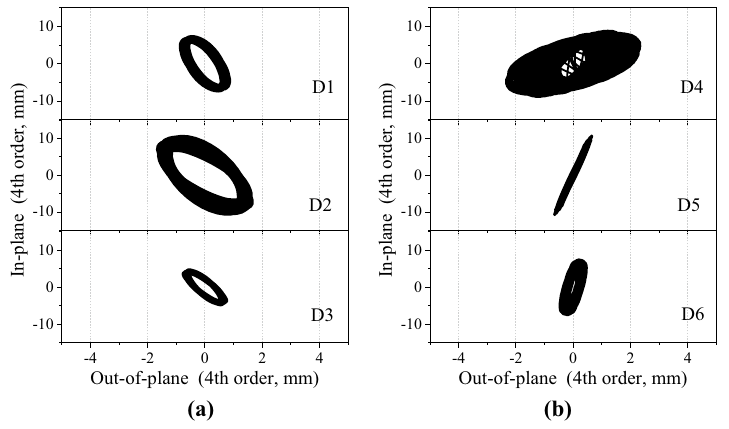
Figure 12. The vibration trajectories for all the measurement points at 15° wind direction when wind speed is 6 m/s: ( a ) measurement points D 1 , D 2 , and D 3 , ( b ) measurement points D 4 , D 5 , and D 6 .